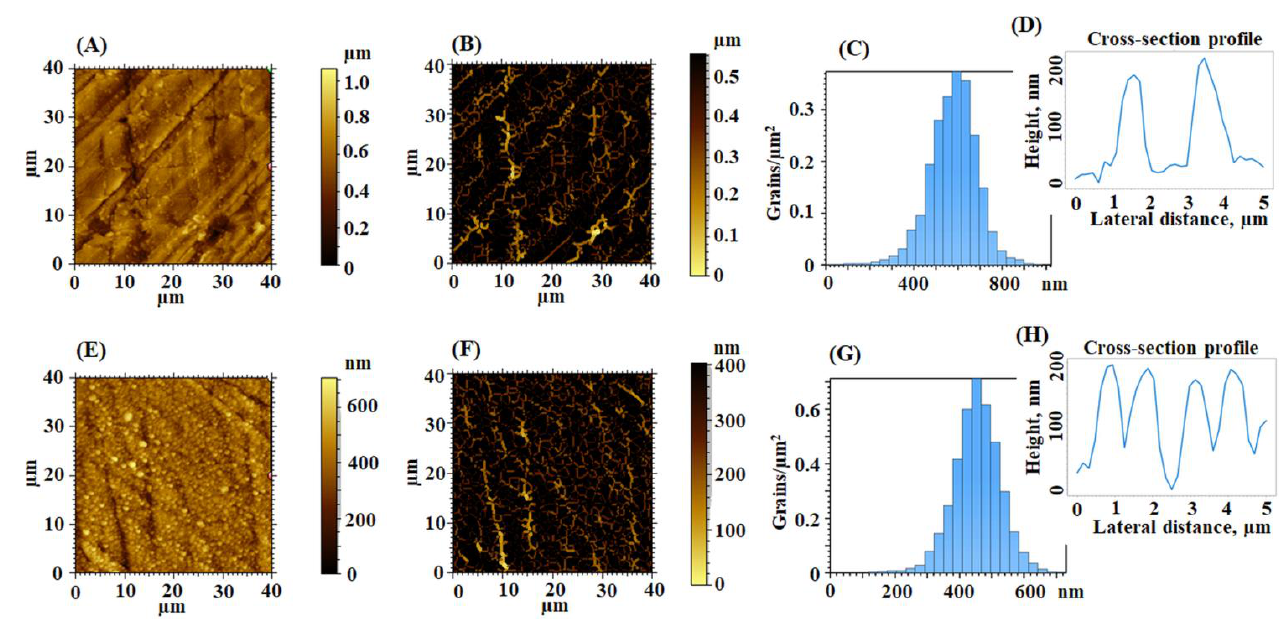
Figure 10. 2D topographical images, furrow maps, grains distribution and grains cross-section profiles obtained for plasma-treated rubbed EPI-pBAPS (3R) ( A – D ) and CBDA-pBAPS (3R) ( E – H ) samples.